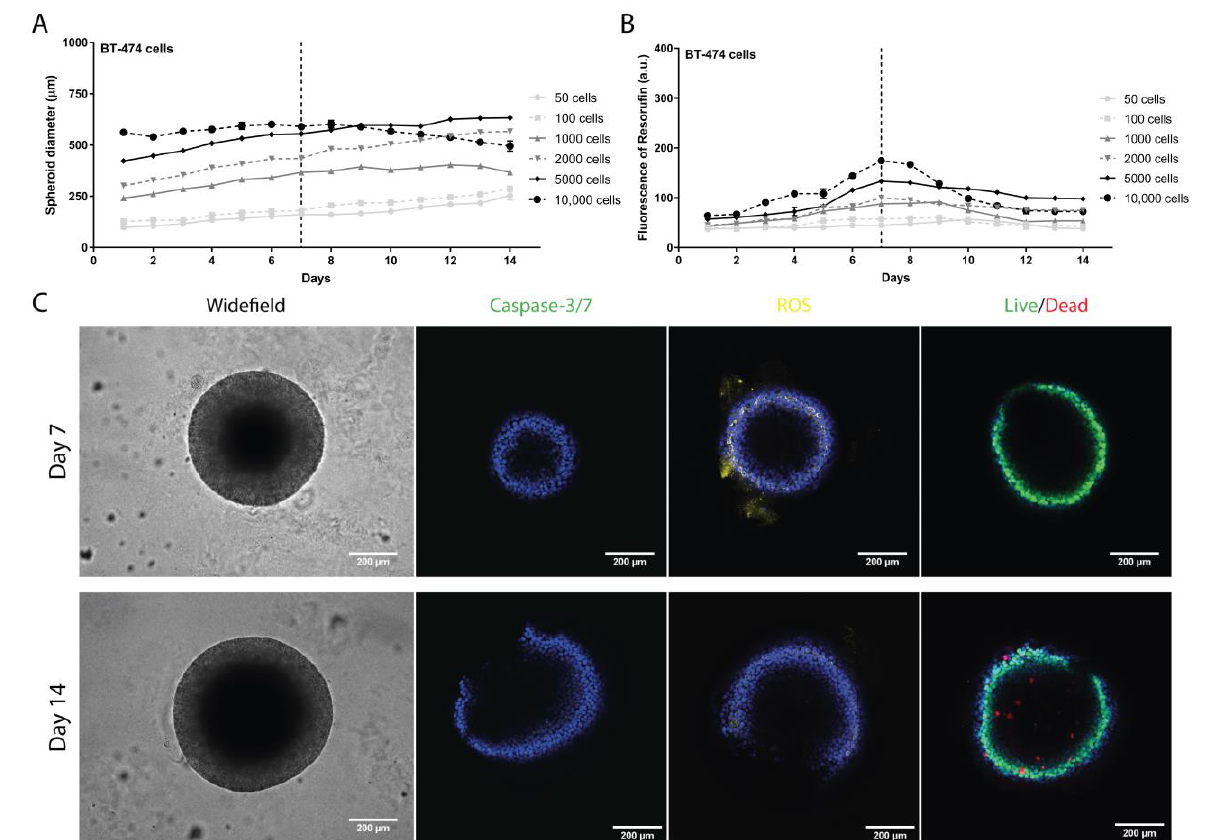
Figure 3. Evaluation of the BT-474 spheroid formation. ( A ) Spheroid diameter ( µ m) daily monitoring over 14 days measured with a widefield fluorescence microscope. ( B ) Spheroid cell metabolic activity daily evaluation over 14 days by measuring the fluorescence emission of resorufin with a microplate reader. ( C ) Representative images of parameters evaluated on days 7 and 14 at 5000 cells/well with a confocal point-scanning Zeiss LSM 880 microscope. In the apoptosis determination, apoptotic cells are marked in green; in the oxidative stress measurement, reactive oxygen species (ROS) are marked in yellow; and in the cell viability/mortality evaluation, intact cells (live) are marked in green and permeabilized cells (dead) in red. In all experiments, cell nucleus is marked in blue. Scale bar = 200 µ m. Graphs represent at least three biological repeats.